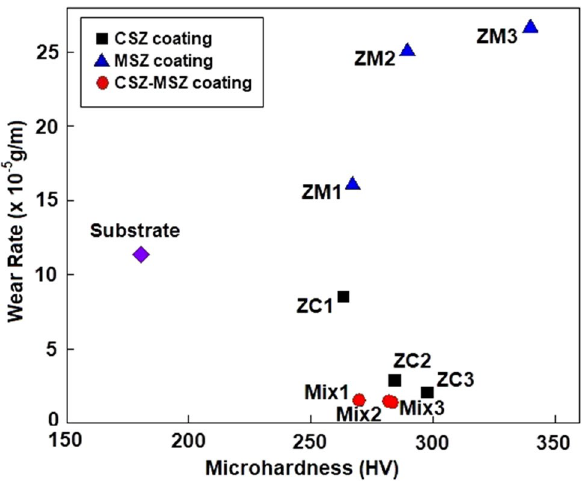
Figure 11. Relationship between the measured wear resistance and microhardness of CSZ, MSZ, and CSZ- MSZ coatings at thickness of 300 μm. The substrate microhardness and wear resistance is provided for